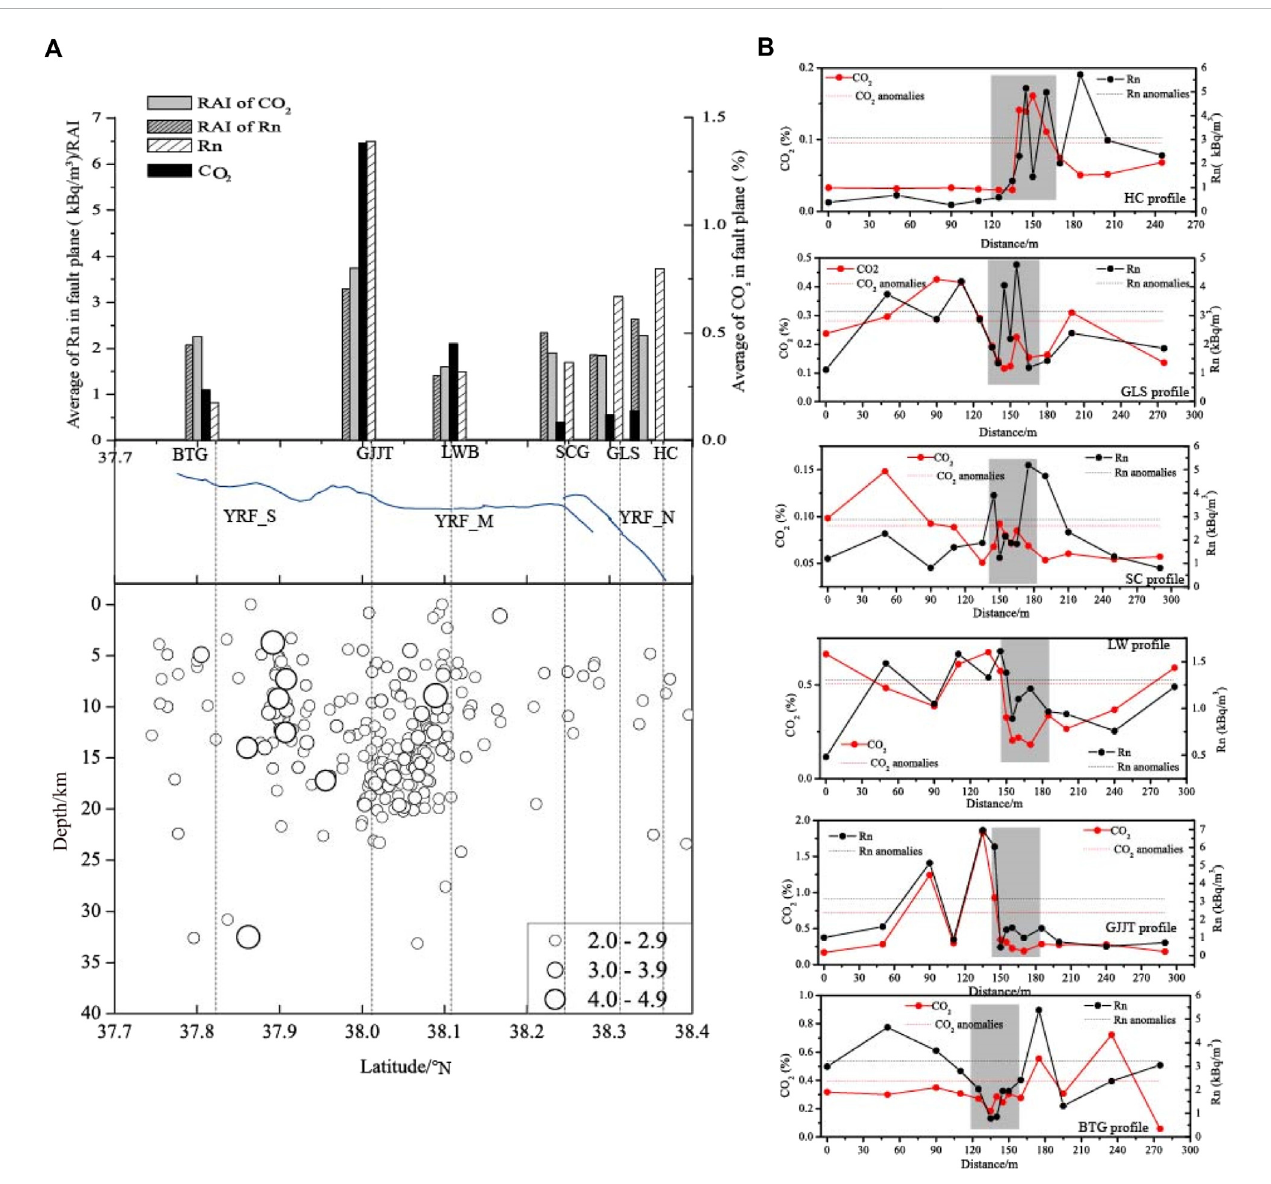
FIGURE 7 Variations in seismic activity and gas concentration along different segments of the Yellow River Fault (gray shading indicates the fault ’ s location, The northern, middle, and southern segments of Yellow River Fault are designated as YRF_N, YRF_M, and YRF_S, respectively).